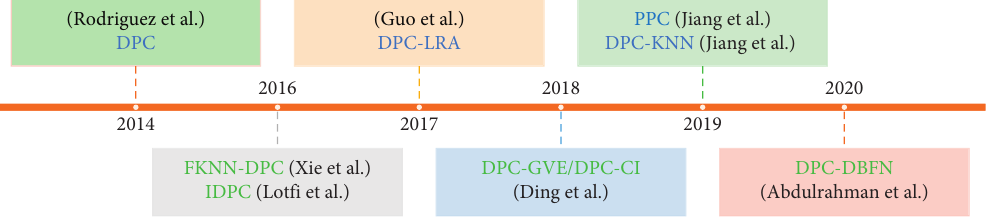
Figure 2: Improvement methods of